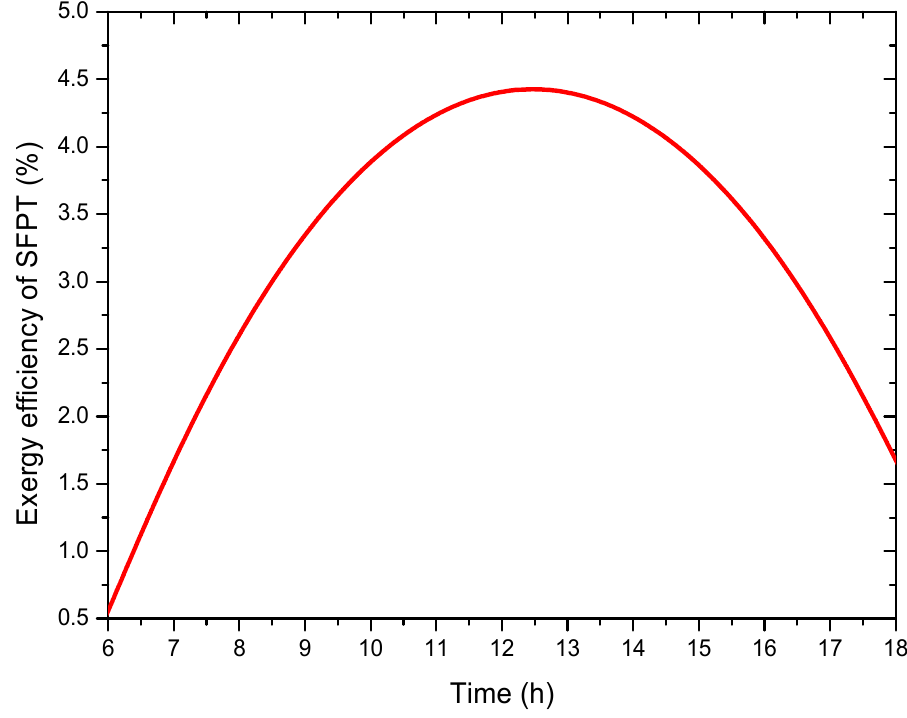
Figure 12. Variation of the collector exergy efficiency variation with a solar with time.